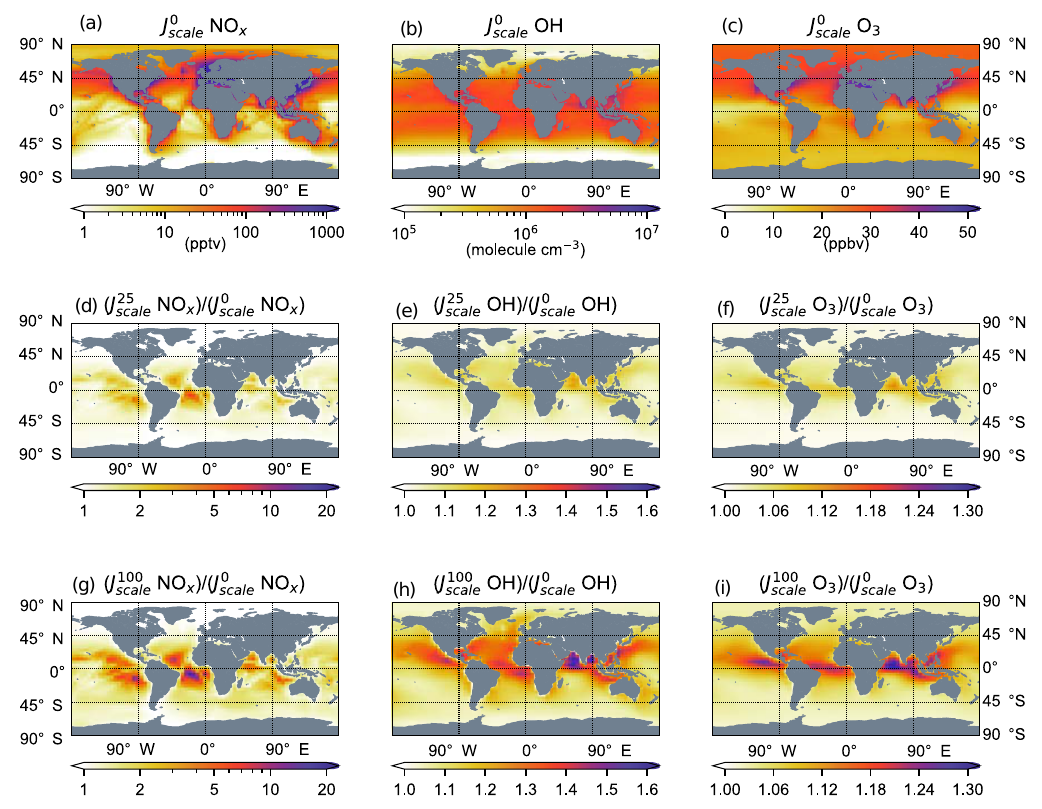
Figure 7. Simulated 2014–2015 MBL-average (average over bottom 1km) concentrations for the J 0 simulated MBL-average concentrations for the J 25 g) , OH (b, e, h) , and O 3 (c, f, i)